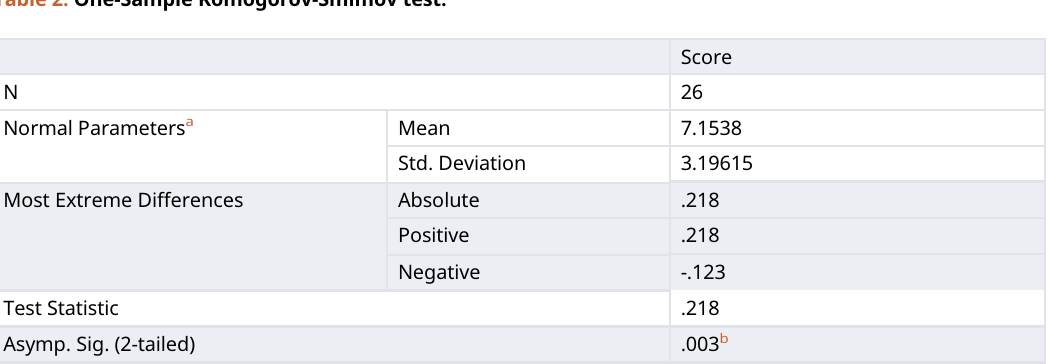
Table 2. One-Sample Komogorov-Smimov